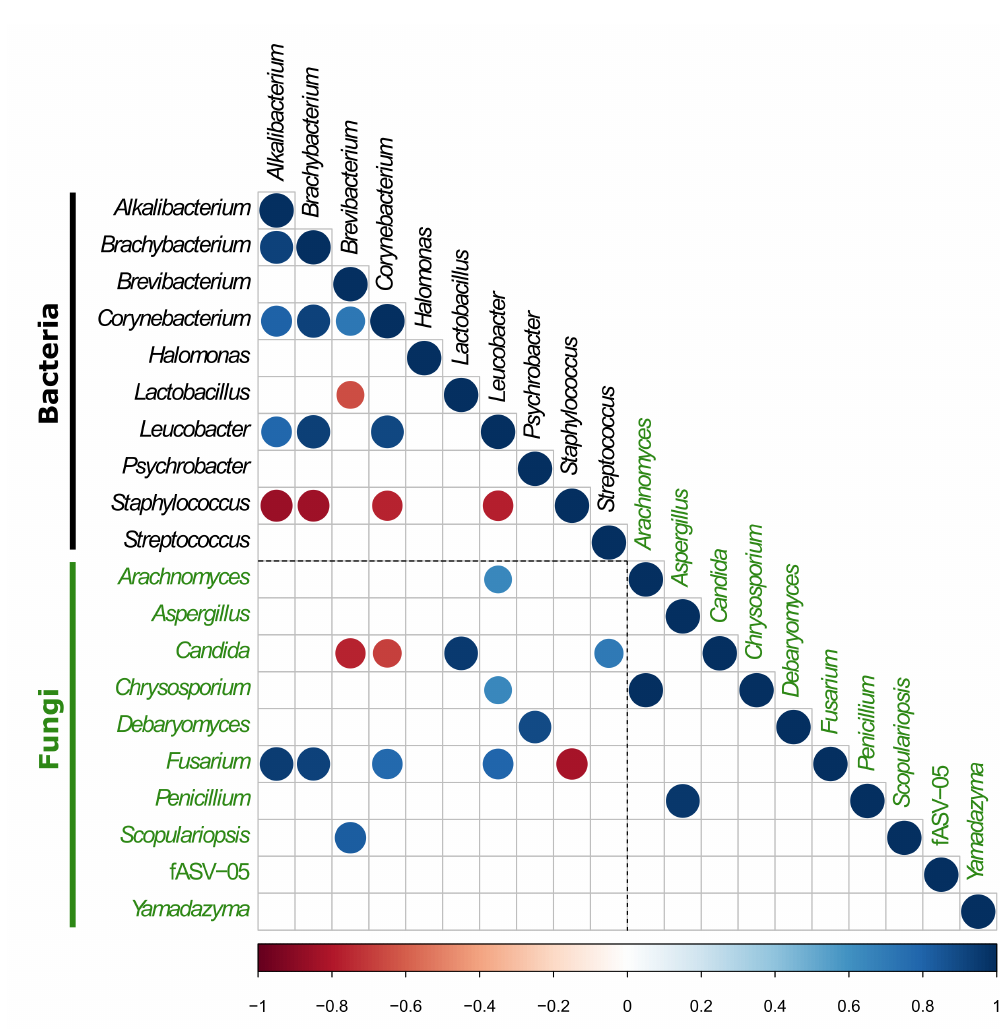
Figure 4. Pearson correlation analysis between the relative abundances of bacterial and fungal genera (obtained after gene-targeted high-throughput sequencing) at the different ripening times and facilities. Only statistically significant correlations are displayed ( p < 0.05). Correlation coefficients are colored from dark red (negative correlation) to dark blue (positive correlation). Color intensity and the size of the circle are proportional to the correlation coefficients. Bacterial and fungal genera names are colored in black and green,